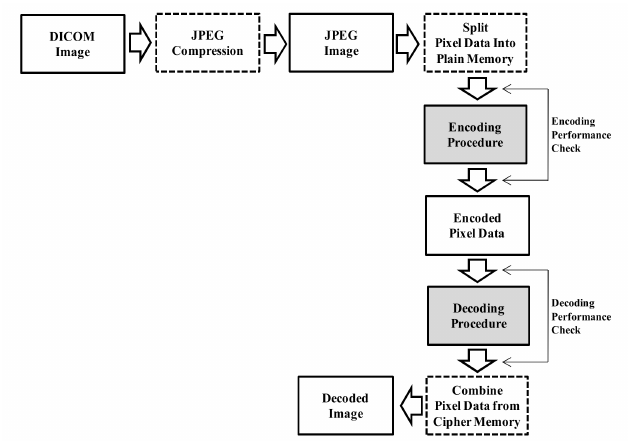
Figure 7. Block diagram for encoding / decoding procedures of the RSA / ECC / proposed algorithms.